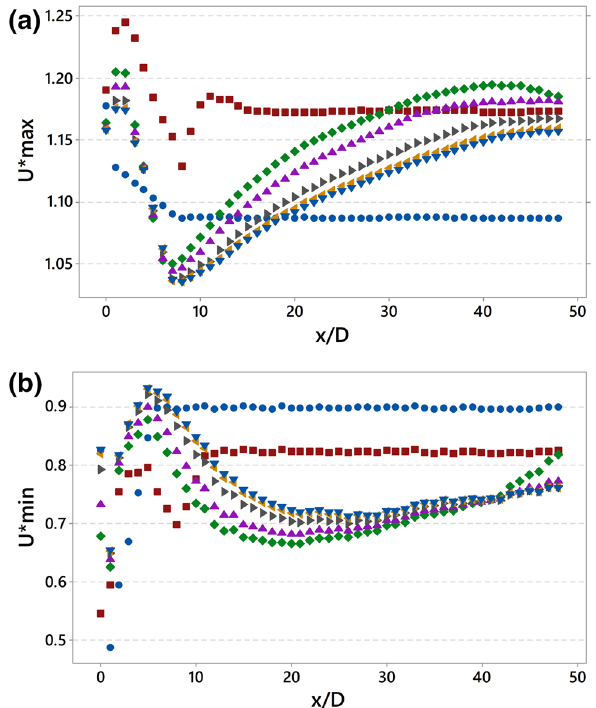
Fig. 4 a Maximum and b minimum time-averaged velocities along the pipe after a long elbow (Setup 2). The velocities should be within 10% of the cross-sectional area average velocity. ● Rey = 5,000; ■ Rey = 10,000; ♦ Rey = 50,000; ▲ Rey = 100,000; ► Rey = 250,000;◄ Rey = 425,000; ▼ Rey =